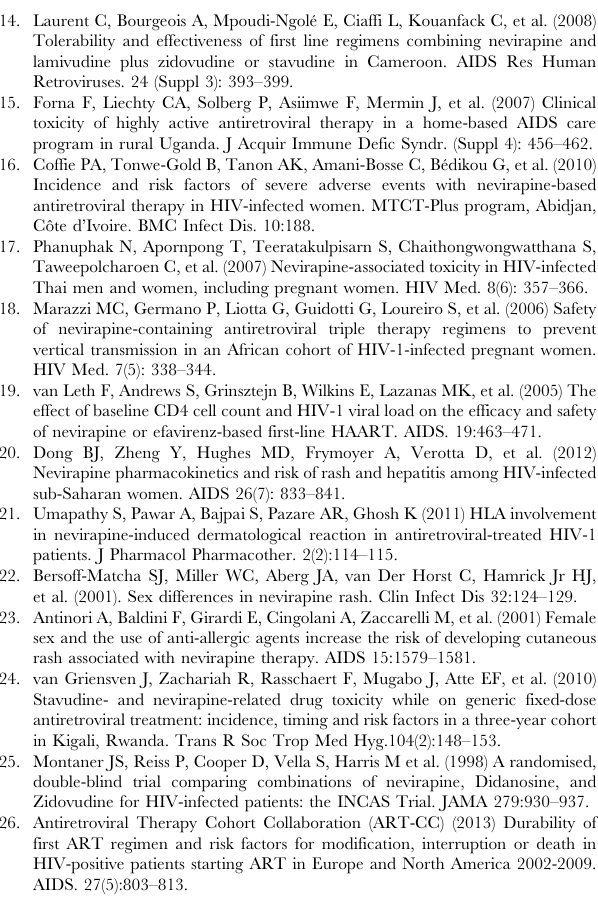
Table S1 Four cases of probable cross-reactive cutane- ous reactions due to NNRTI class